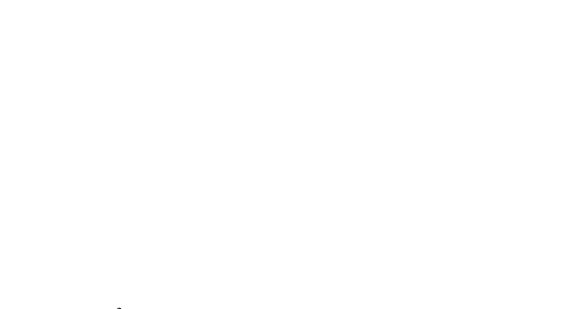
Table 5. Variable effects of the acceptable fiber rate in the 2 3 factorial designs. The